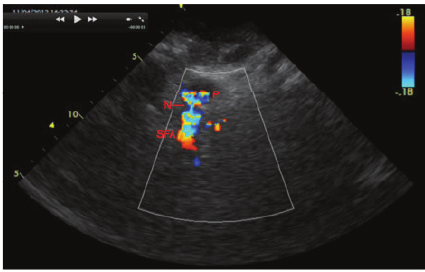
Figure 1: Ultrasound image: pseudoaneurysm sac (P) communi- cates via a neck (N) with the superficial femoral artery (SFA). Colour Doppler demonstrates flow within the pseudoaneurysm.